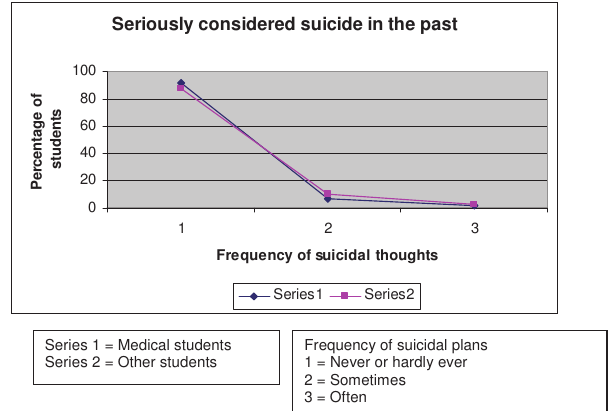
Fig. 5. Suicidal ideation.